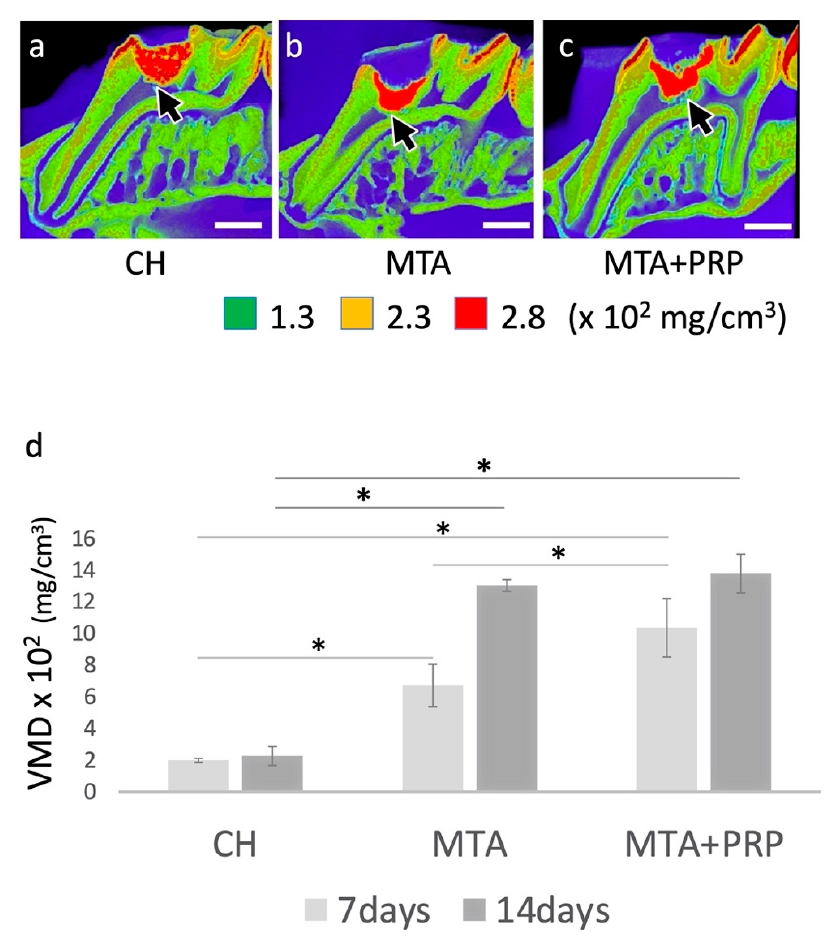
Figure 1. The µ CT images with mineral density (MD) at 14 days, and MD volume (VMD) at 7 days and 14 days after pulp capping. High MD images (arrows) were found under the pulp-capping materials at 14 days after direct pulp capping: ( a ) CH; ( b ) MTA; ( c ) MTA + PRP. Note that both MTA and MTA + PRP were filled uniformly; however, CH was filled heterogeneously. ( d ) Each property of the dentin bridges beneath the pulp-capping materials showed various VMD values. Scale bars: 1.0 mm; * p < 0.05.